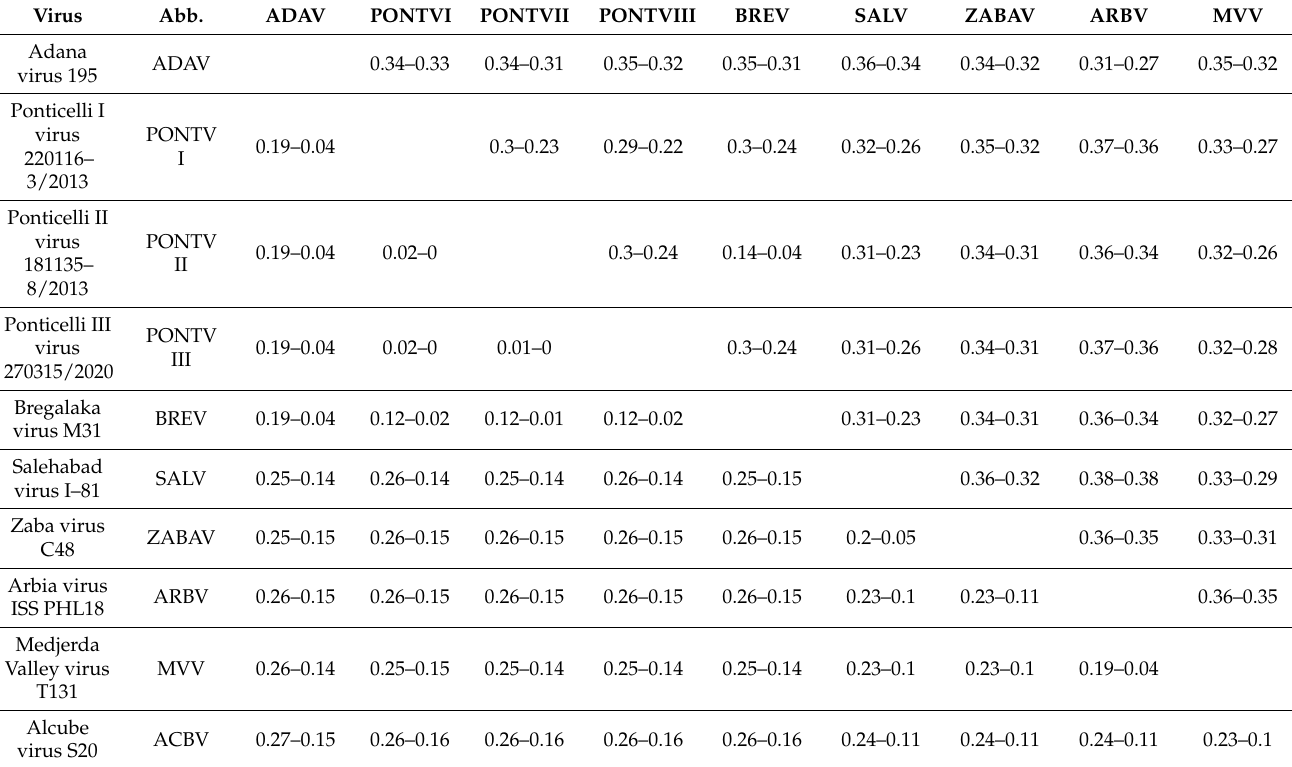
Table 2. Nucleotidic and amino acidic p distance between L (lower right) and M segments (upper left). According to the ICTV rule, virus with an aminoacid diversity of L segment < 0.05 can be considered the same